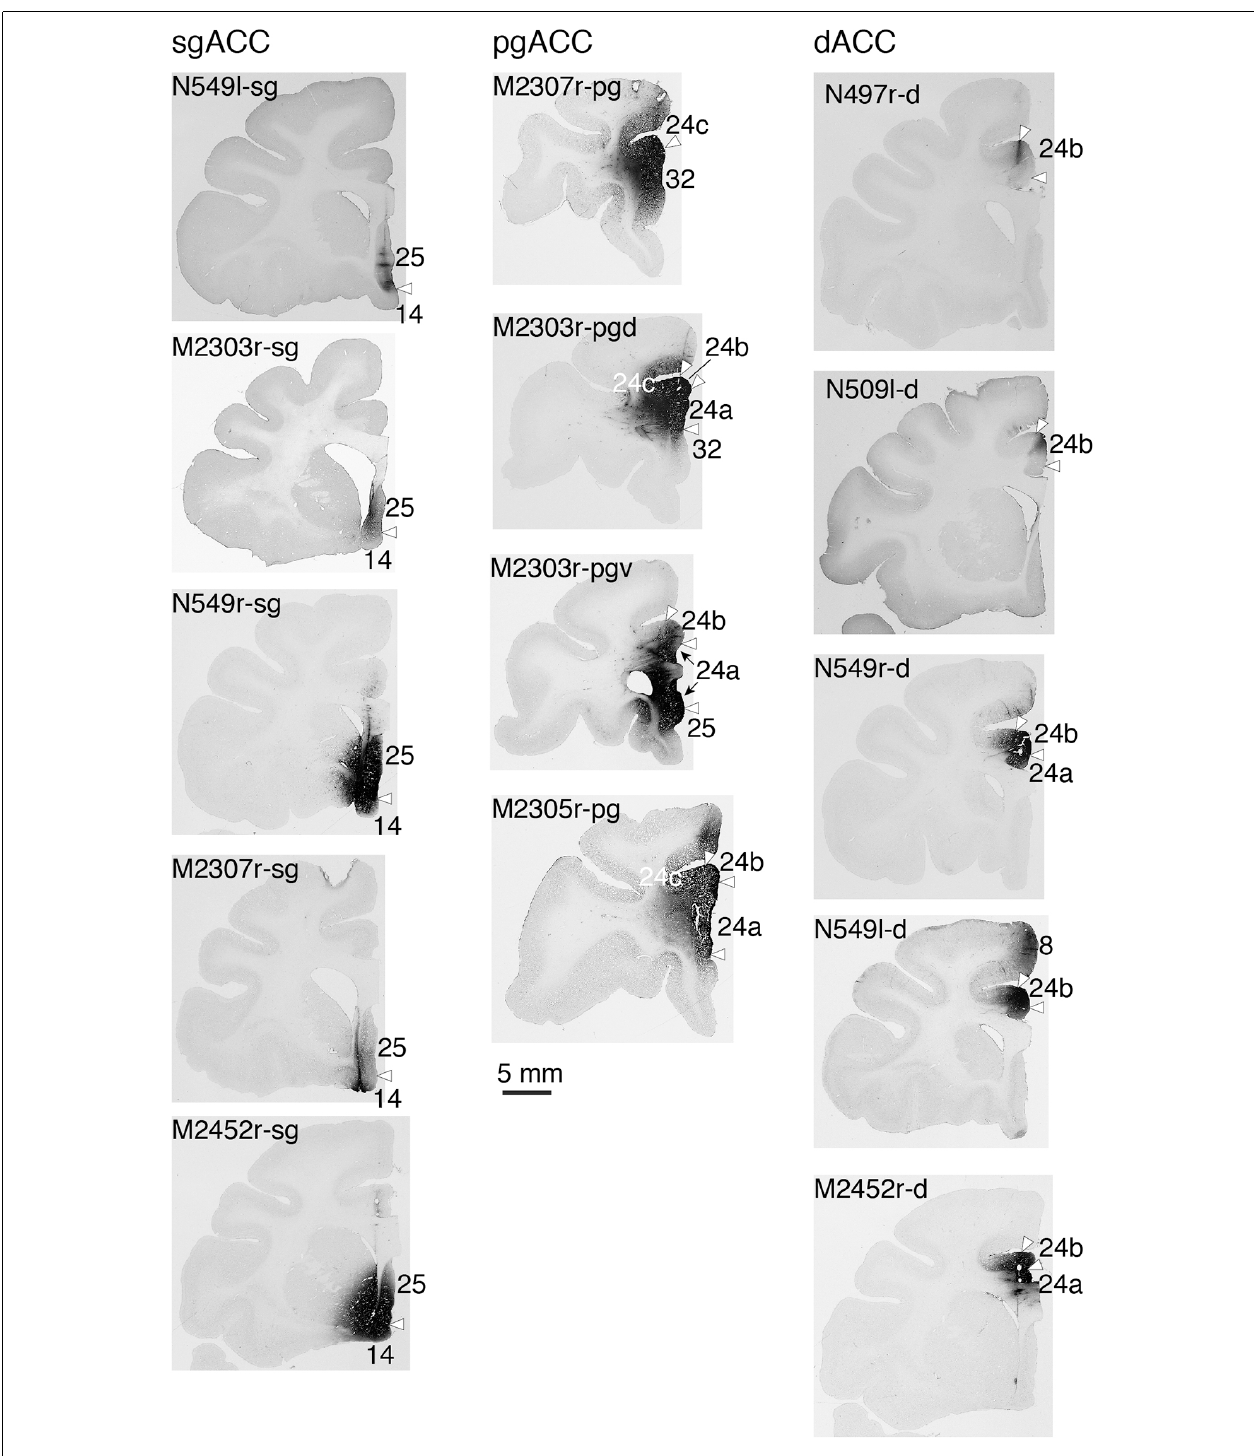
FIGURE 2 | Photographs of the brain sections through the center of injection.